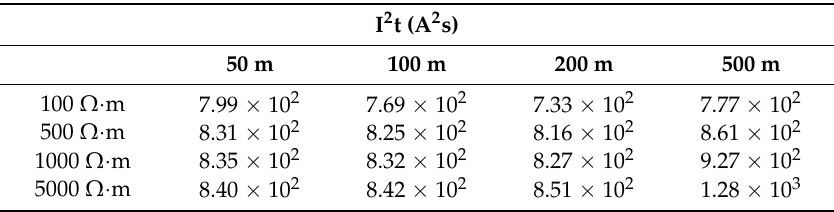
Table 5. Let-through energy due to lightning strike in the MV